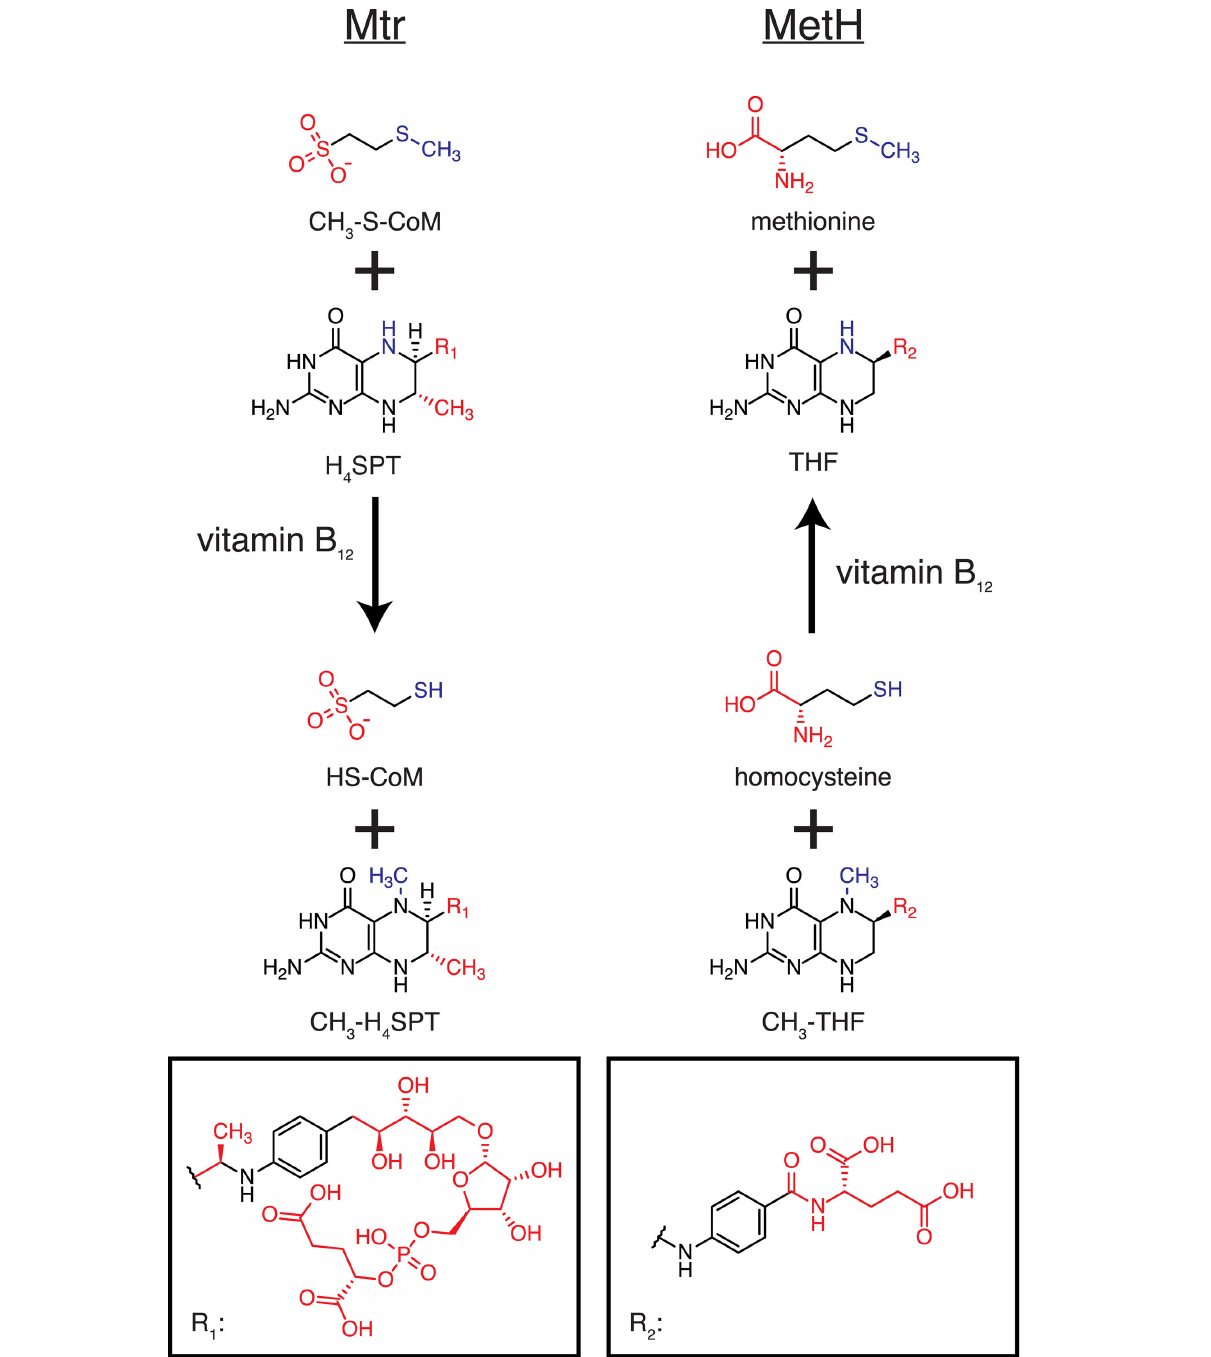
homocysteine bind (PDB 1Q8J) (Evans et al., 2004), and these binding sites are distant from the enzyme’s catalytic machinery (Evans et al., 2004). The specific activity of MetH is about 2-fold higher than that of CmtA (Huang et al., 2007; Vepachedu and